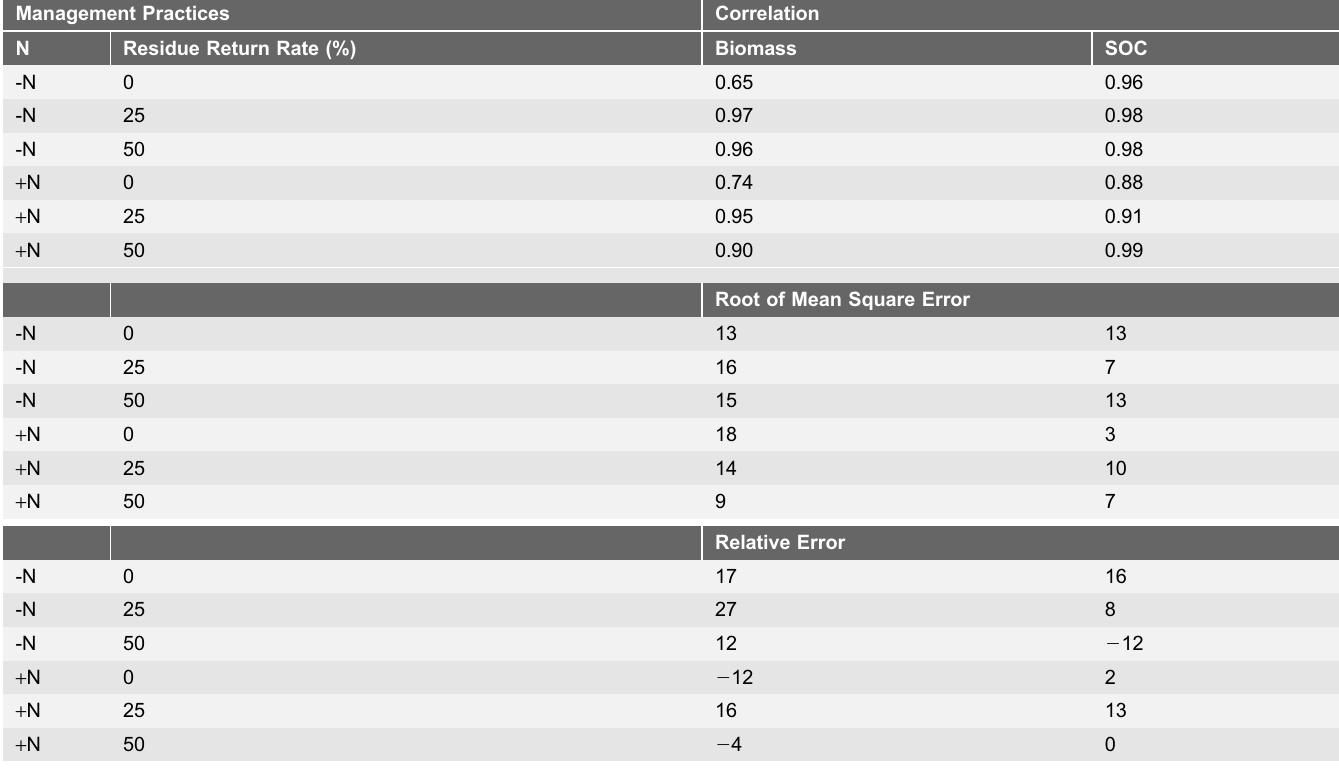
Table 2. Statistical tests applied for agreement between simulated and measured values of biomass yield and soil organic C (SOC) under bioenergy sorghum production at College Station,